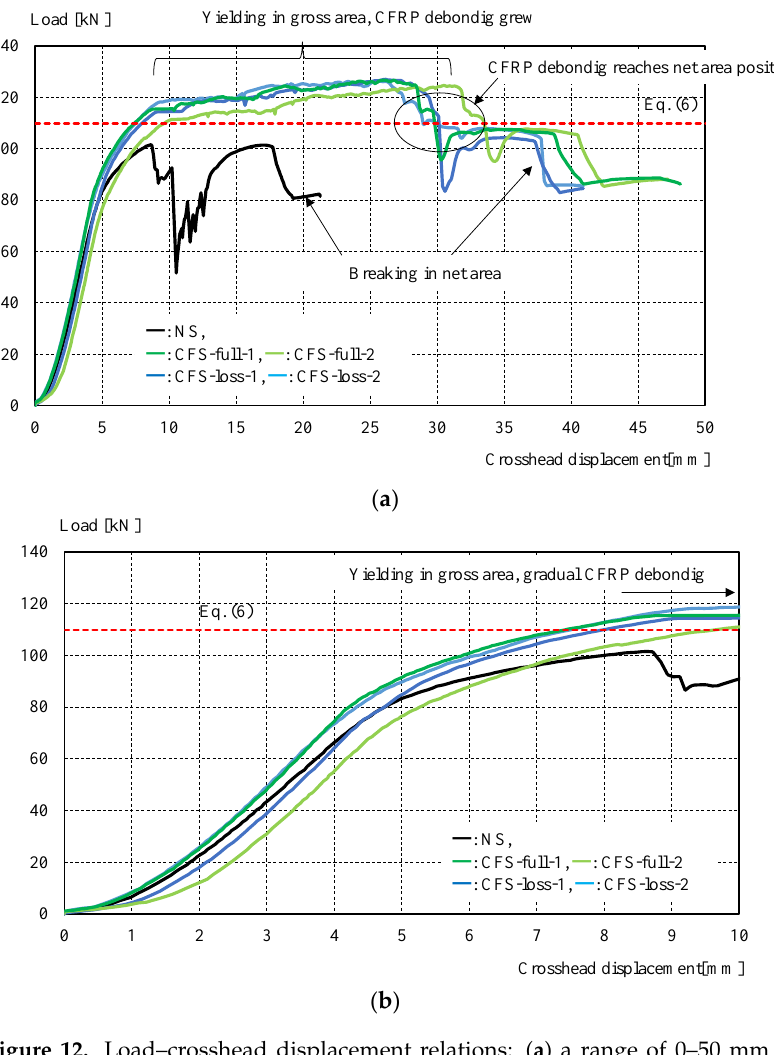
Figure 12. Load–crosshead displacement relations: ( a ) a range of 0–50 mm with experimental observation; ( b ) a range of 0–10 mm.